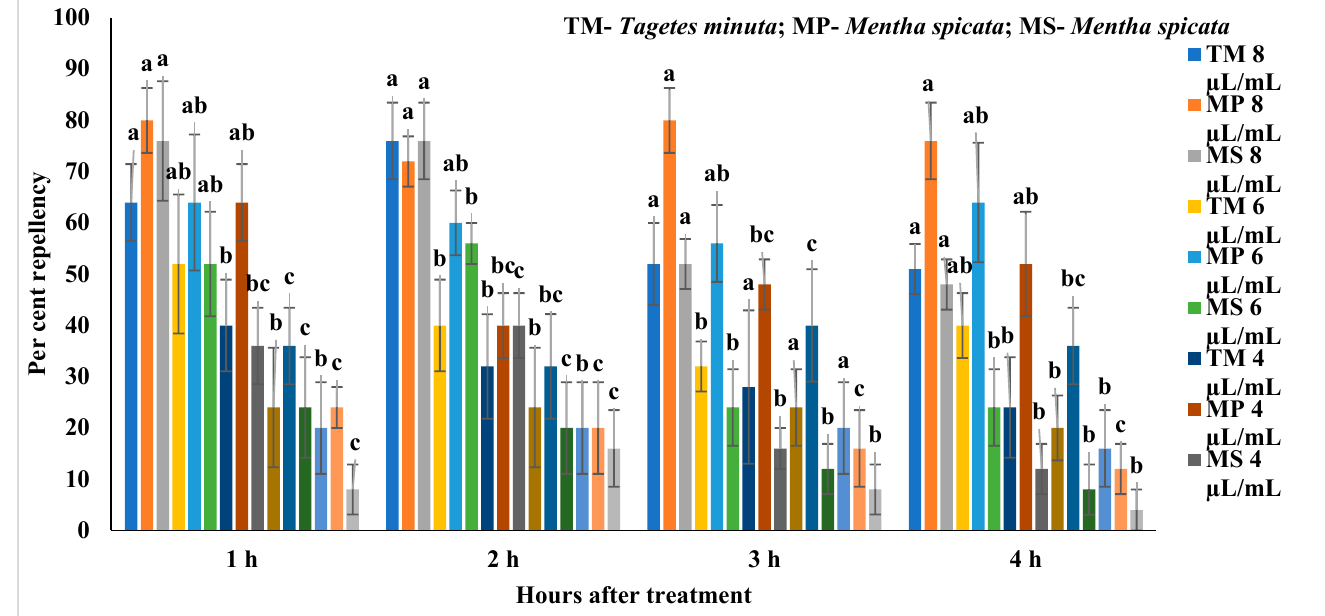
Figure 2. Repellence of essential oils against Callosobruchus maculatus ; Means followed by the same letter within the error bars are not statistically different by Tukey ( p ≤ 0.05).